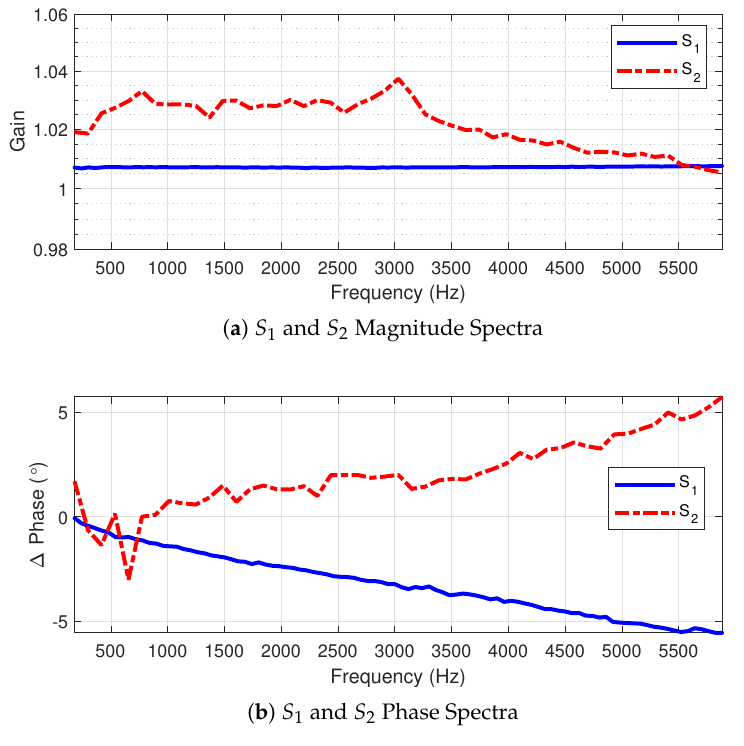
Figure 1. Frequency response curves for both test sensors, S 1 and S 2 , up to 5